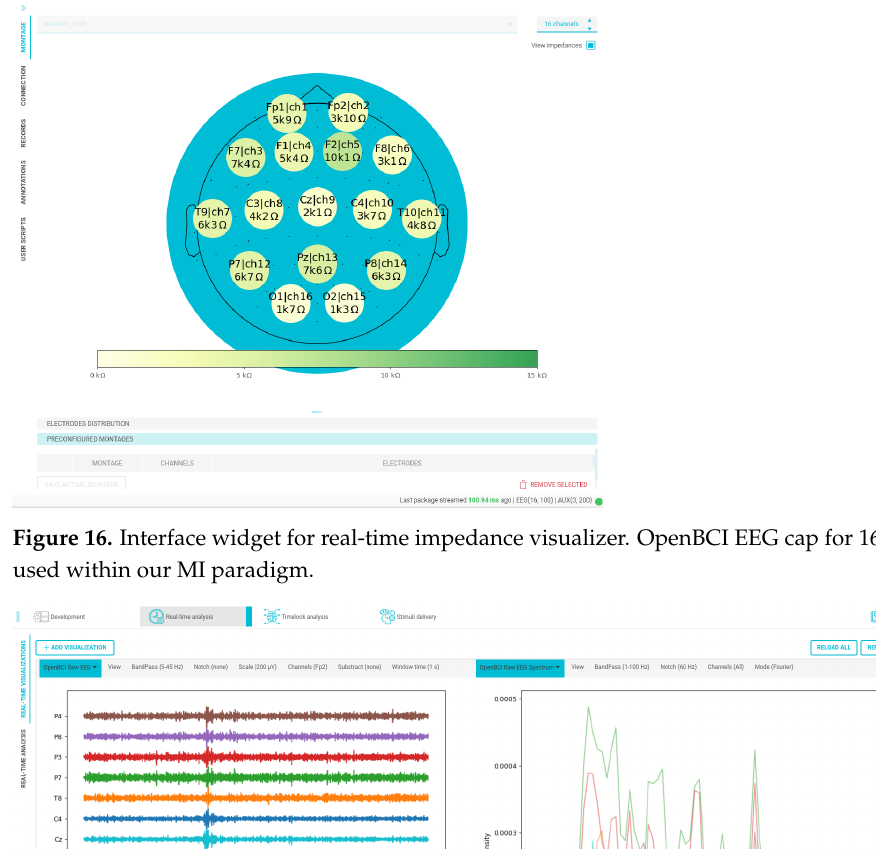
Figure 19. Integrated development interfaces displaying areas for code editing, file explorer, experiment preview, and debugging area for our OpenBCI Framework Future work will extend the proposed framework to 32 and 64 EEG channels [47,48]. 494 This work uses the OpenBCI Cyton board, one of the highest-performing hardware devices. 495